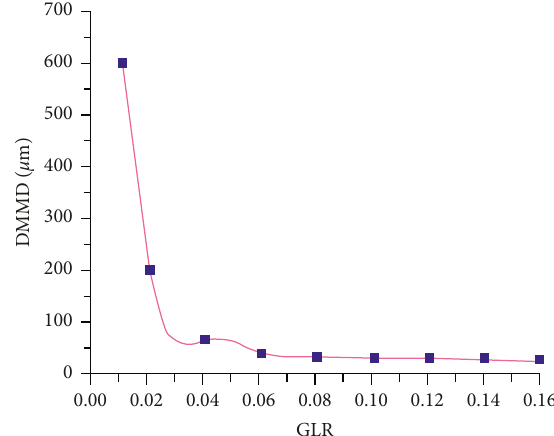
Figure 4: Dependence of the mass mean diameter and the